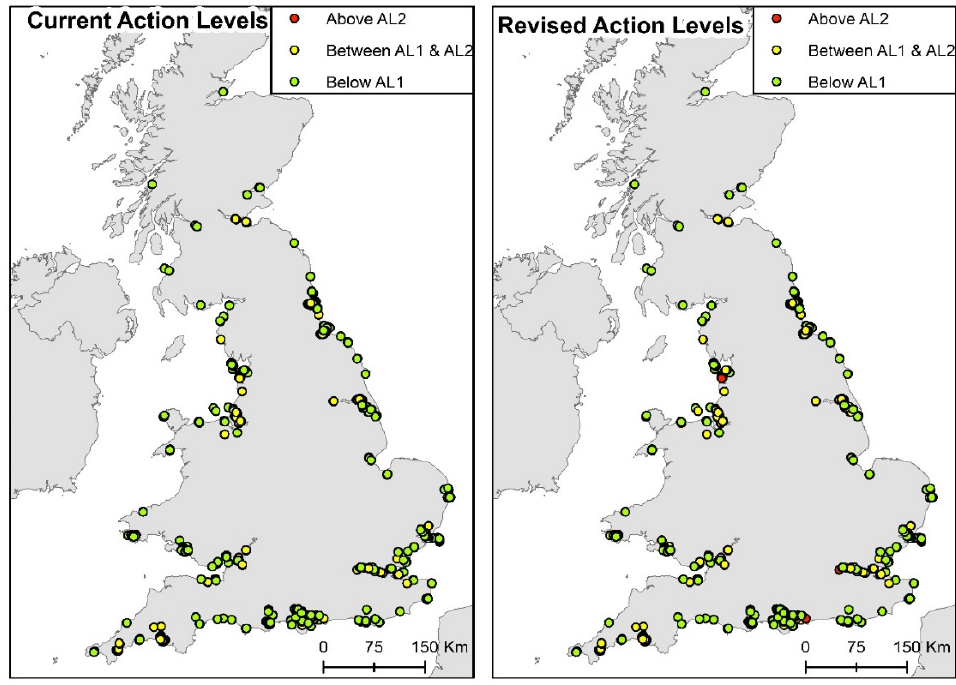
Figure 3. Maps showing the differences between the current ALs and revised ALs for mercury (Hg). Samples above AL2 are indicated in red. Figure adapted from [13].